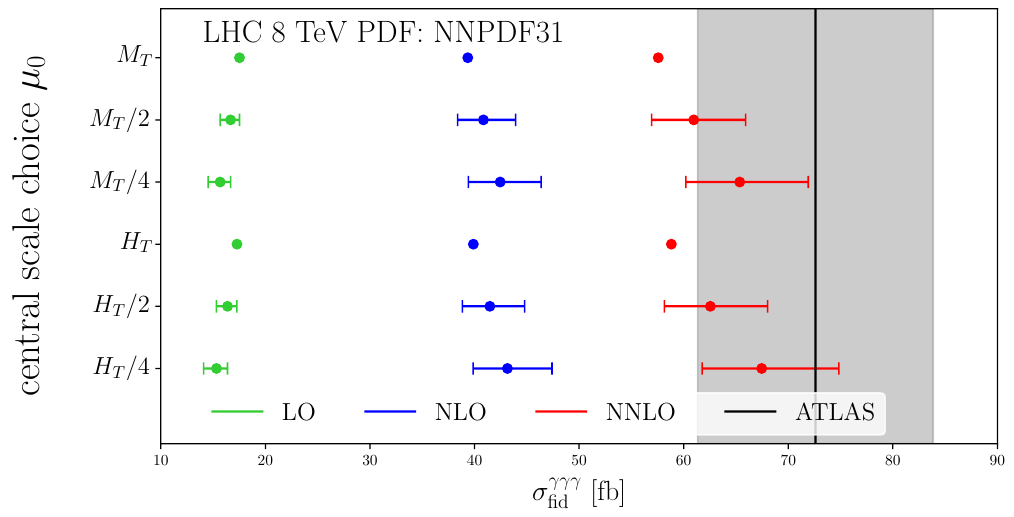
Figure 1 . Predictions for the (cid:12)ducial cross-section in LO (green), NLO (blue) and NNLO (red) QCD versus ATLAS data (black). Shown are predictions for six scale choices. The error bars on the theory predictions re(cid:13)ect scale variation only. For two of the scales only the central predictions are